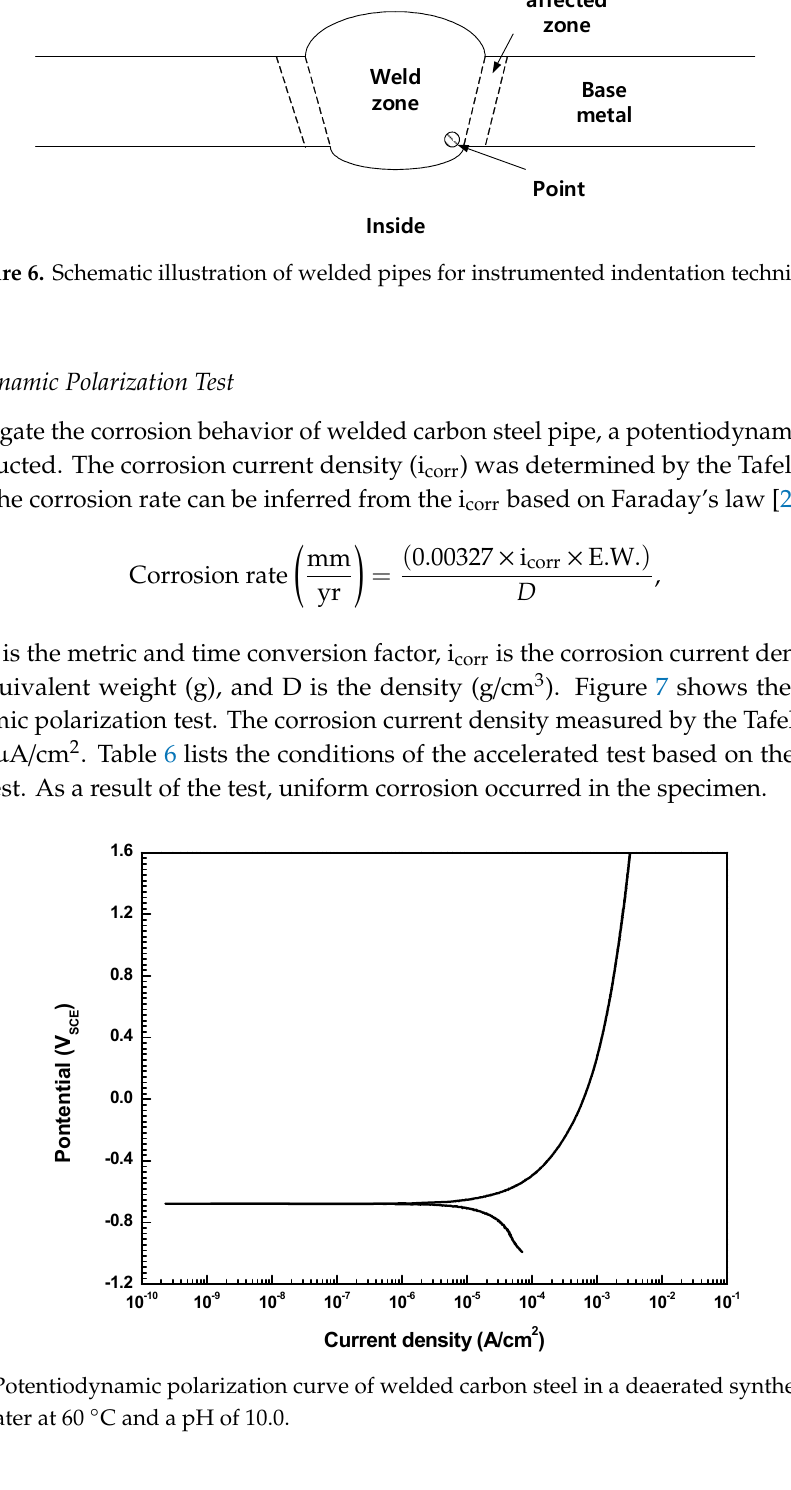
Figure 6. Schematic illustration of welded pipes for instrumented indentation technique.